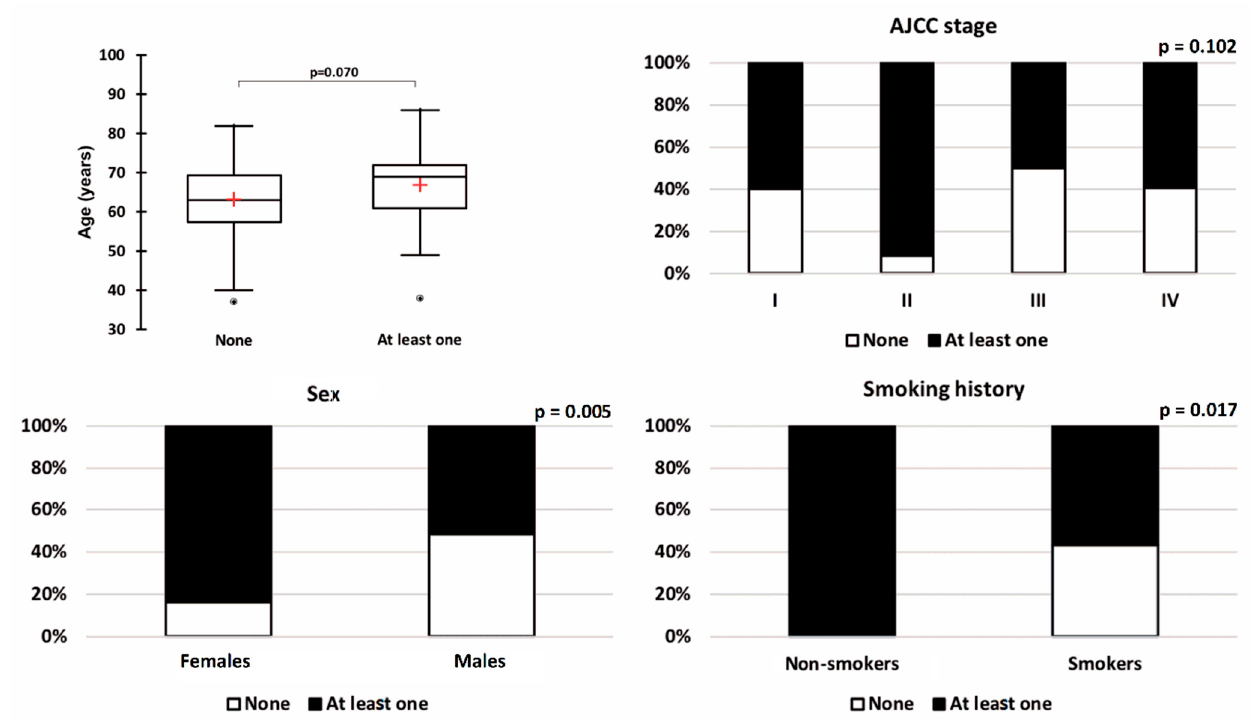
Figure 4. Comparison of patients without any molecular alteration and patients with at least one for all the clinical variables included in the model.